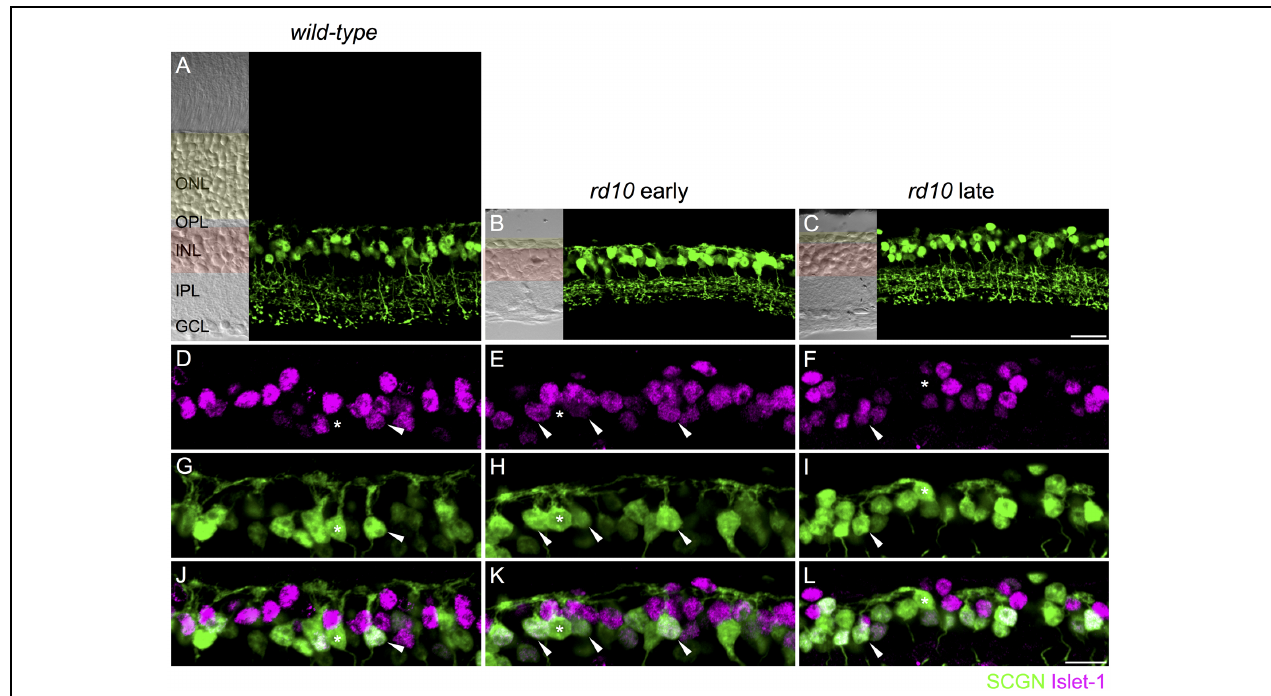
FIGURE 1 | On and Off cone bipolar cells retain dendrites after extensive photoreceptor degeneration. (A–C) Confocal micrographs showing secretagogin immunoreactive cone bipolar cells in wild-type ( A , 8 months of age) and rd10 retina (B,C) . Transmitted light images are displayed to the left of each panel to show retinal morphology. The outer nuclear layer (ONL) is shaded in yellow and the inner nuclear layer (INL) in red. OPL, outer plexiform layer; IPL, inner plexiform layer; GCL, ganglion cell layer. (D–L) High power micrographs of the outer retina showing double labeling for Islet-1 ( D–F, magenta) and secretagogin (SCGN, G–I , green). Merged images are shown in panels (J–L) . Examples of Off cone bipolar cell somata (Islet-1 negative, SCGN positive) with connected dendrites are indicated with asterisks. Examples of On cone bipolar cell somata (Islet-1 positive, SCGN positive) with connected dendrites are indicated with arrowheads. Scale bar in (C) (applies to A–C ) = 20 μ m, in (L) (applies to D–L ) = 10 μ